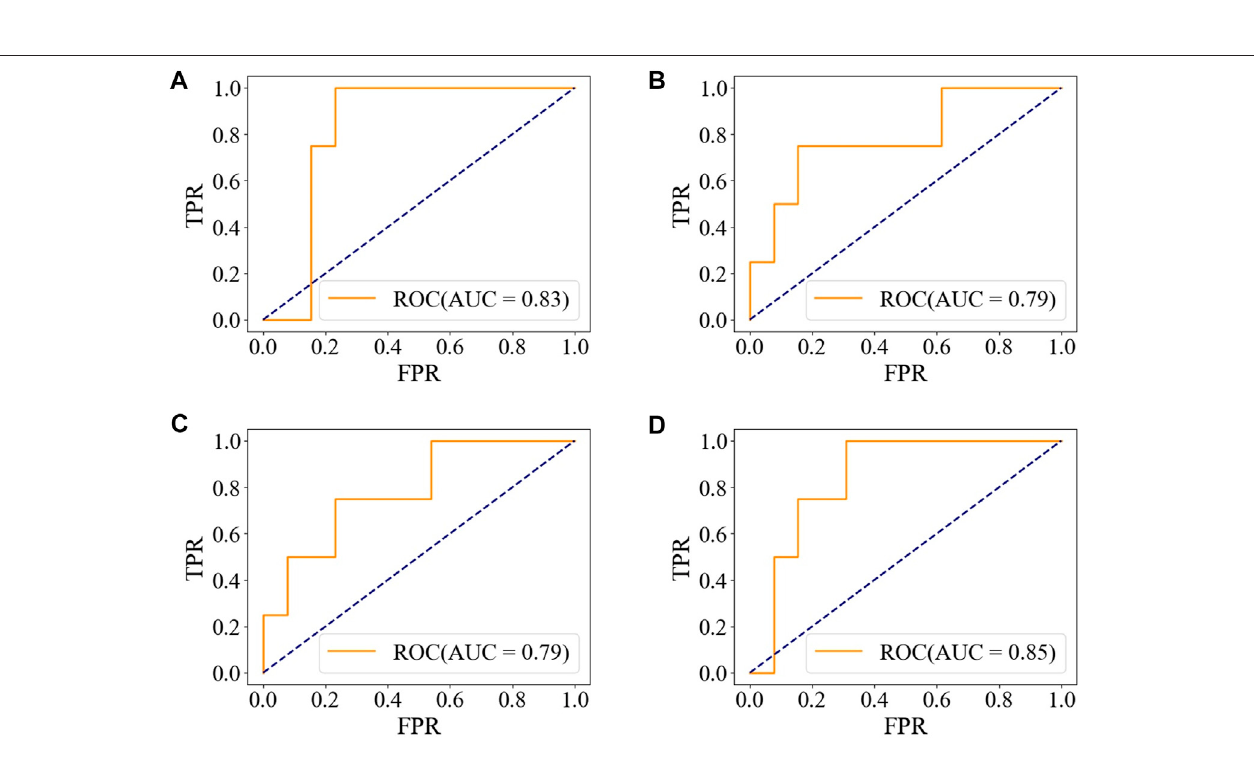
Frontiers in Pharmacology |